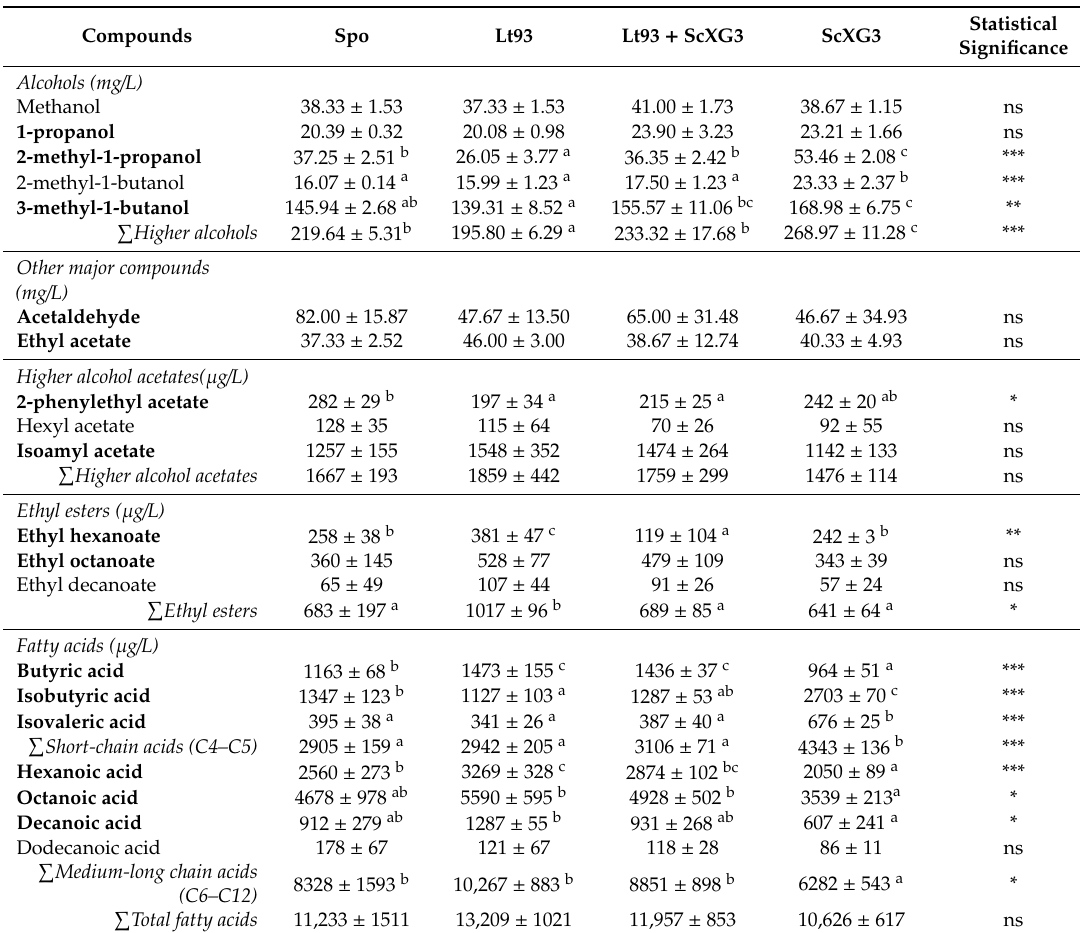
Table 3. Concentration of volatile compounds in Treixadura wines elaborated with S. cerevisiae ScXG3, L. thermotolerans Lt93, sequential fermentation of both strains and by spontaneous fermentation (Spo).